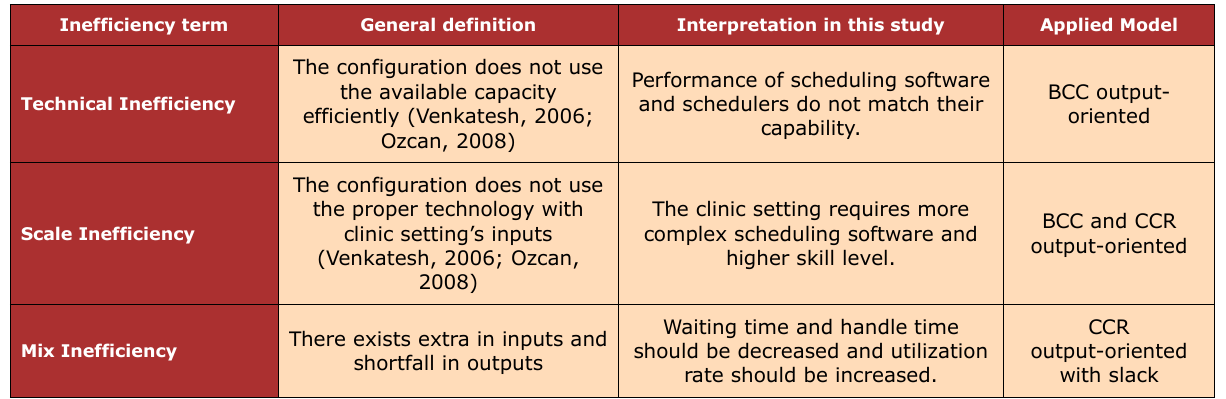
Table 1. Different terms of